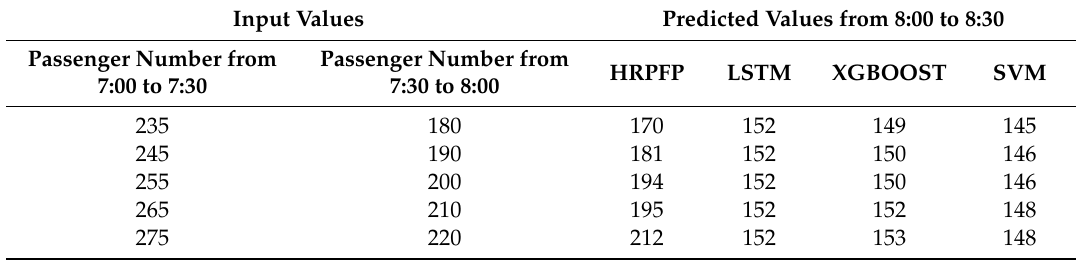
Table 2. A simple case of the 8th station in line 56008 on the sensitivity of di ff erent models. Input